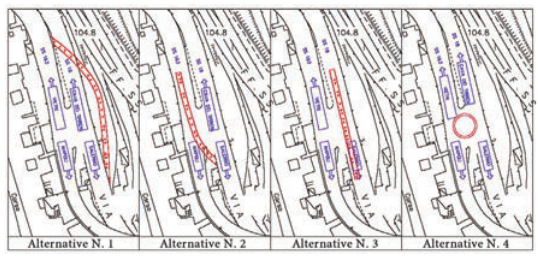
Fig. 5. Alternative Table 4. Criteria and sub-criteria weights Weights Criteria